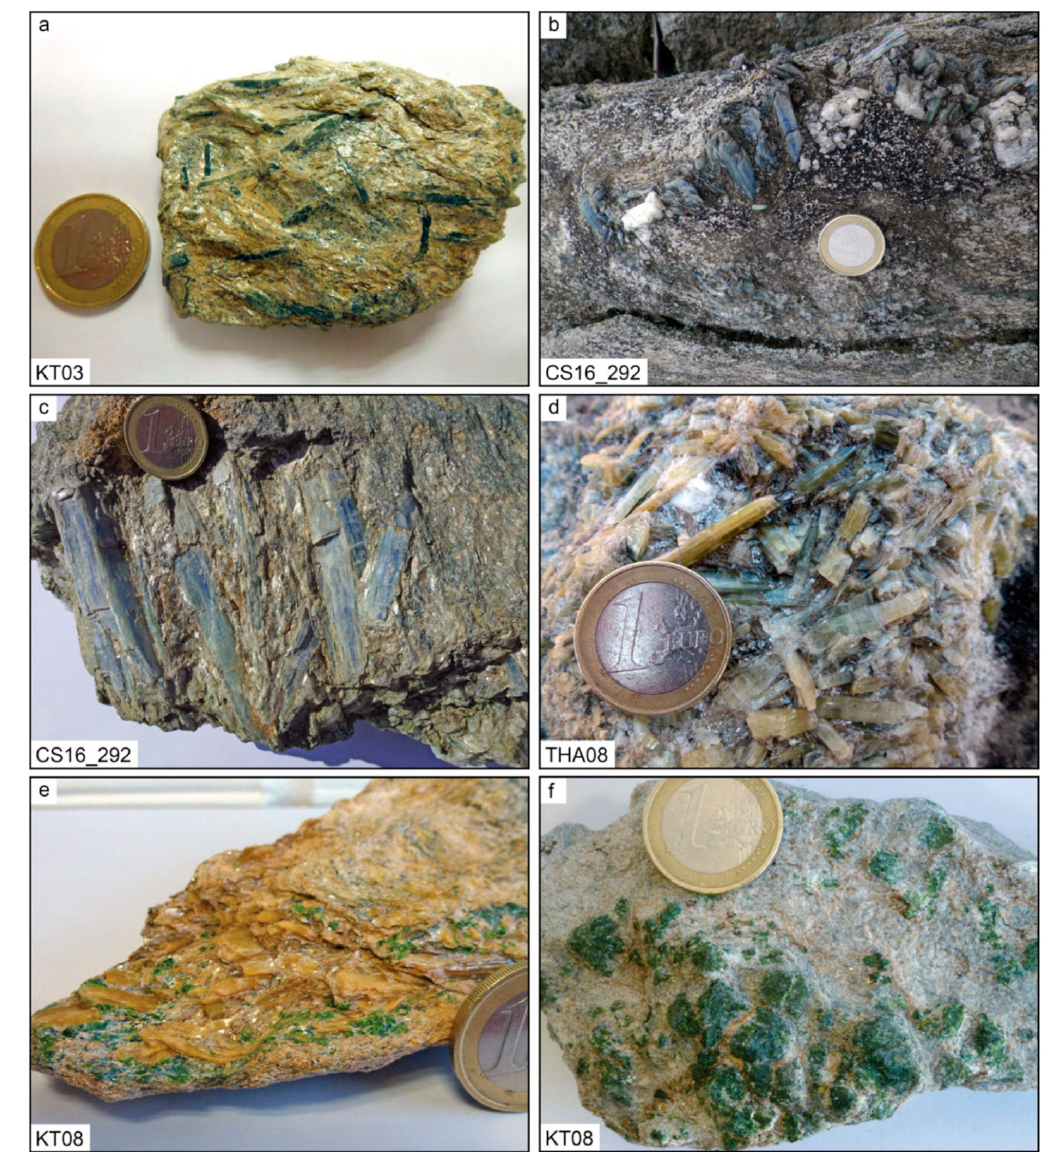
Figure 4. Di ff erent kyanite color types encountered in the Trikorfo area (Thassos Island). ( a ) Unoriented dark blue kyanite in a mica schist collected towards the top of the area. ( b ) Zoned blue (core) to green-transparent (rim) kyanite in a deformed and folded quartz vein. The pluricentimetric kyanite crystals are found at the interface between the gneiss and the vein. The crystals are weakly deformed and generally oriented parallel to the rock lineation. ( c ) Close-up on zoned-blue kyanite mostly aligned parallel to the rock foliation. ( d ) Field photograph of zoned dark blue-yellow isotropically distributed kyanite crystals in a quartz vein. ( e ) Orange kyanite crystals, generally oriented parallel to gneiss lineation, associated with green Mn-rich andalusite (viridine) and quartz. ( f ) Aggregate of centimetric green Mn-bearing andalusite